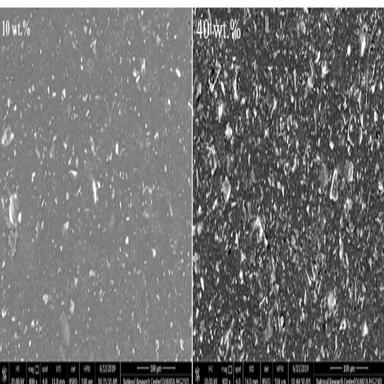
SEM for polyester doped 10% and 40% Ni0.5Zn0.5Fe2O4 nanoparticles.